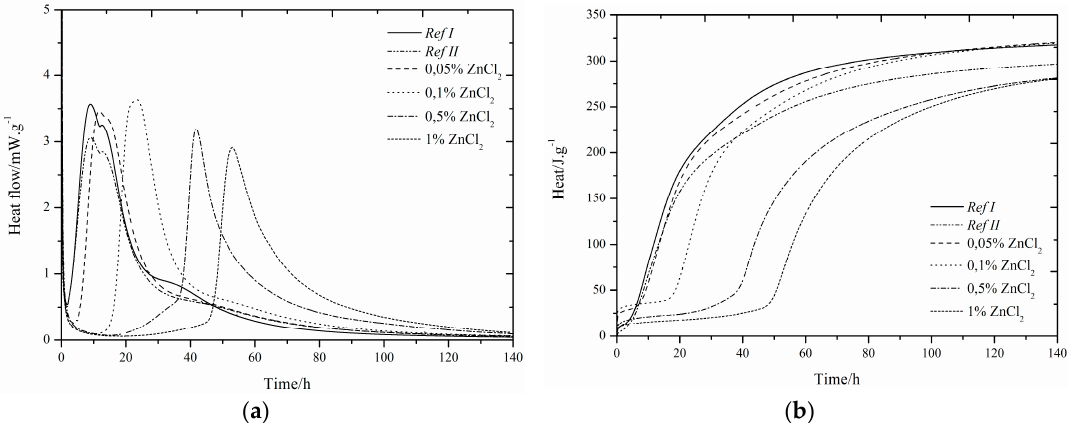
Figure 4. Differential ( a ) and integral ( b ) curves measured for theaddition of ZnCl 2 . Figure 4. Di ff erential ( a ) and integral ( b ) curves measured for theaddition of ZnCl 2 . Due to doping the samples with zinc, the main hydration peak gradually increased and then merged, as well as the samples with Zn(NO 3 ) 2 and in the case of pure cement. The course of